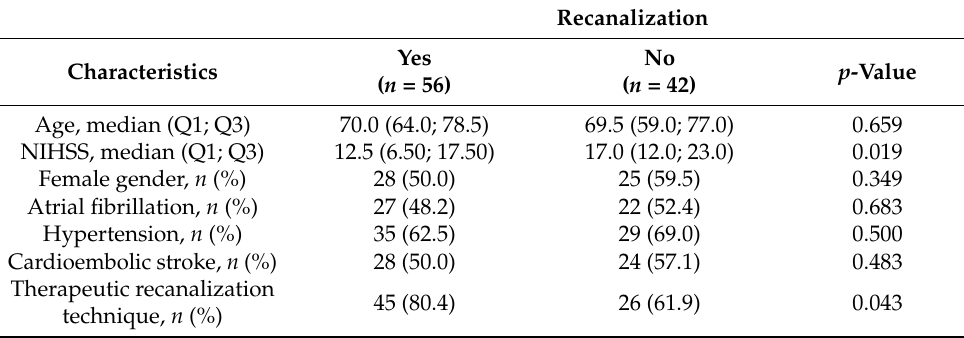
Table 3. Recanalization success, according to the patients’ clinical characteristics.